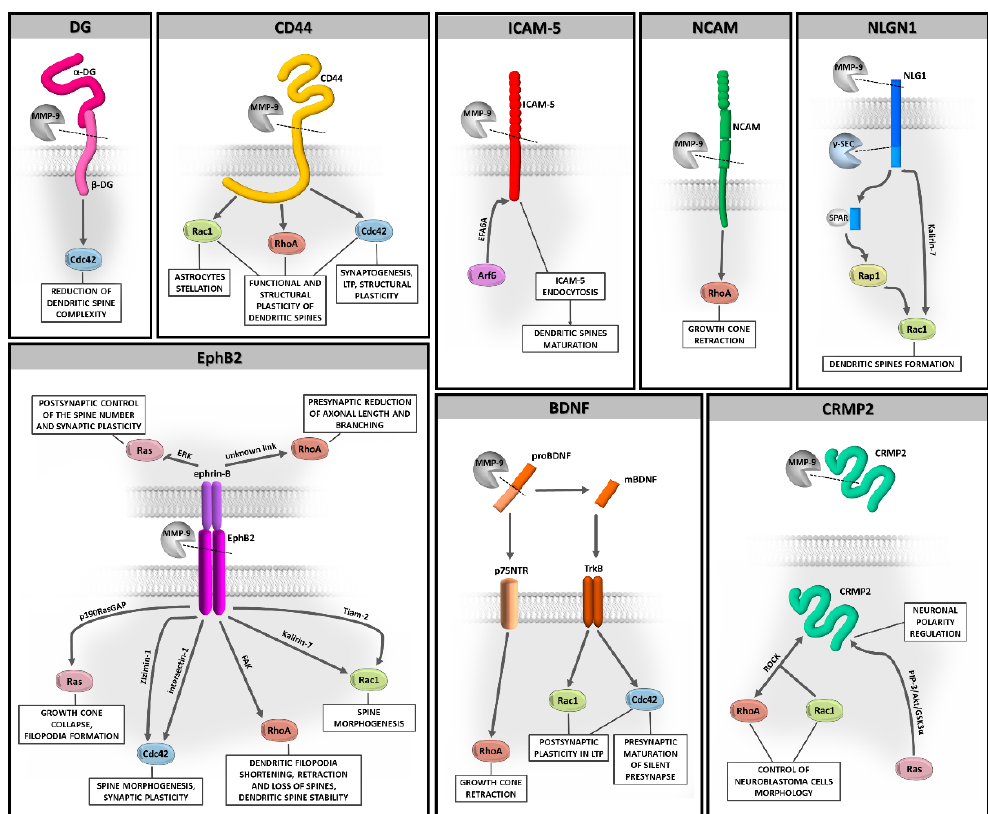
Figure 2. The potential relationship between MMP-9-driven substrates shedding and Rho GTPases signaling in brain plasticity.